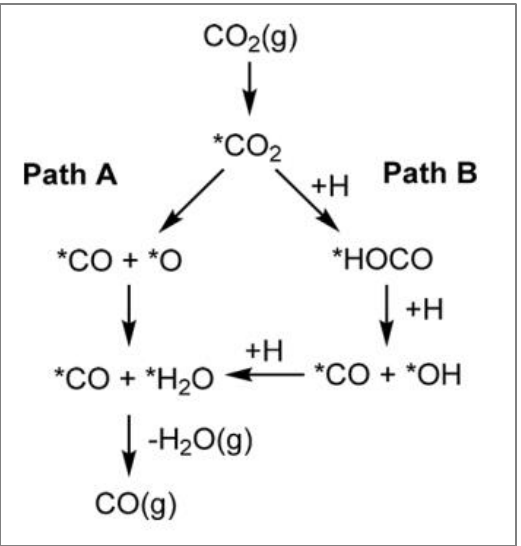
Figure 21. The main proposed pathways for the rWGS reaction. Reproduced with permission from Ref. [174]. Copyright© 2020, American Chemical Society.